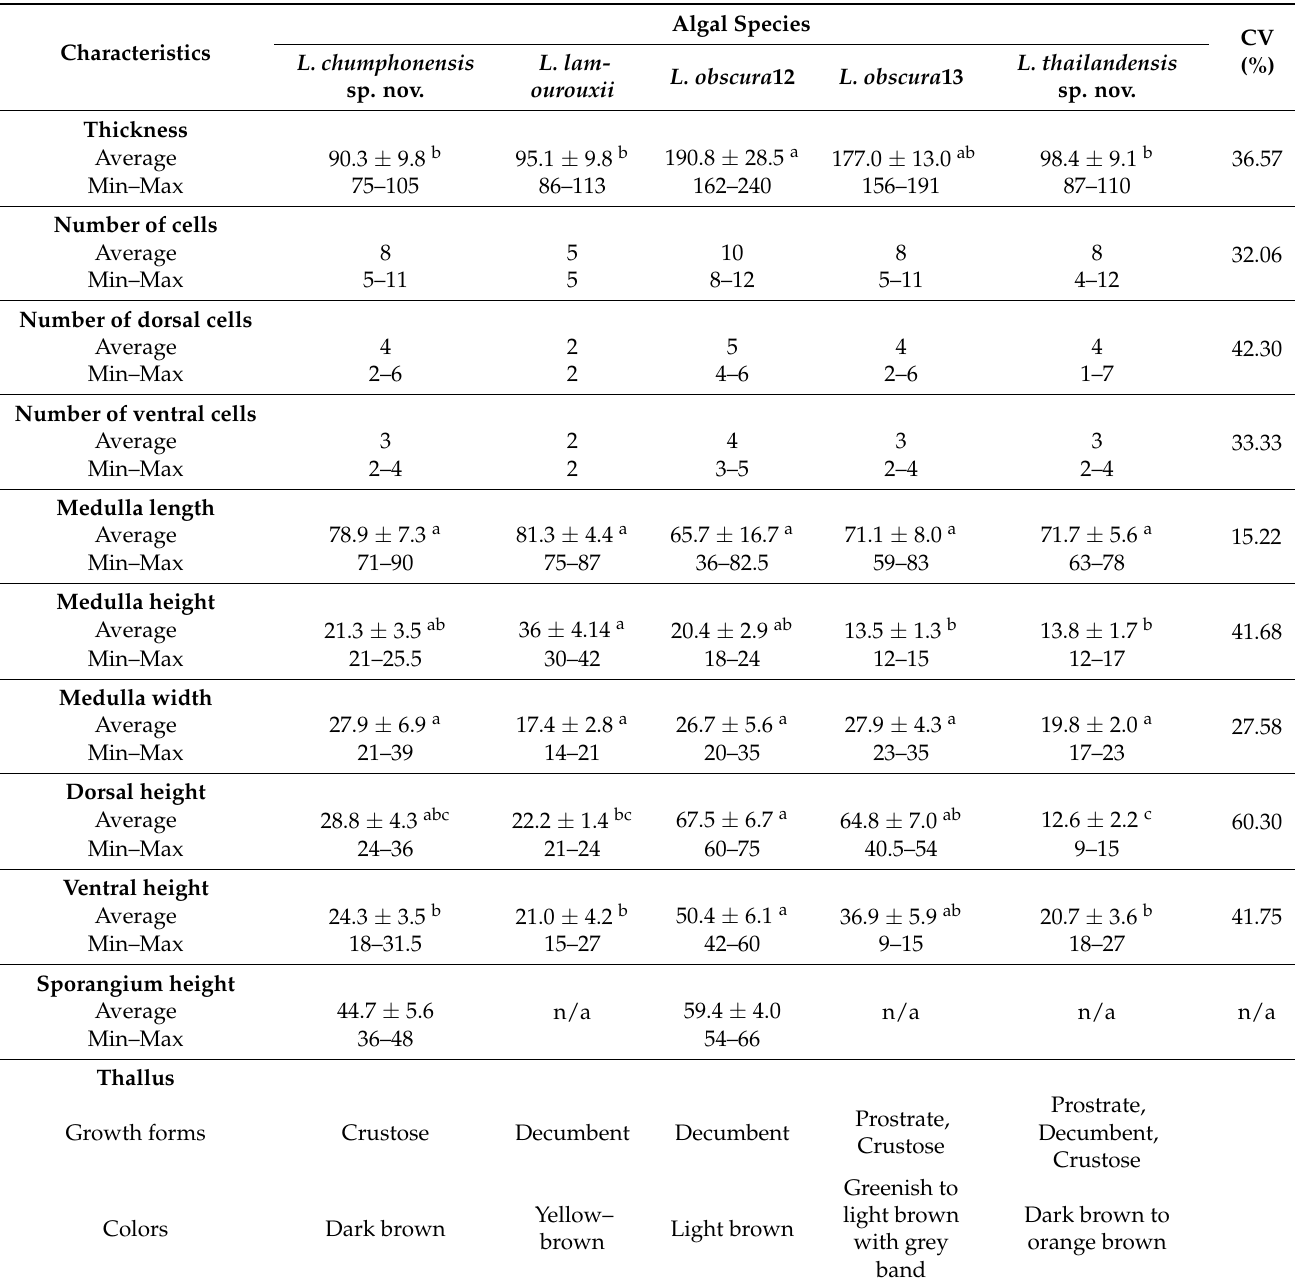
Table 1. Comparison of morphological and anatomical characteristics among species of the brown alga Lobophora from the western Gulf of